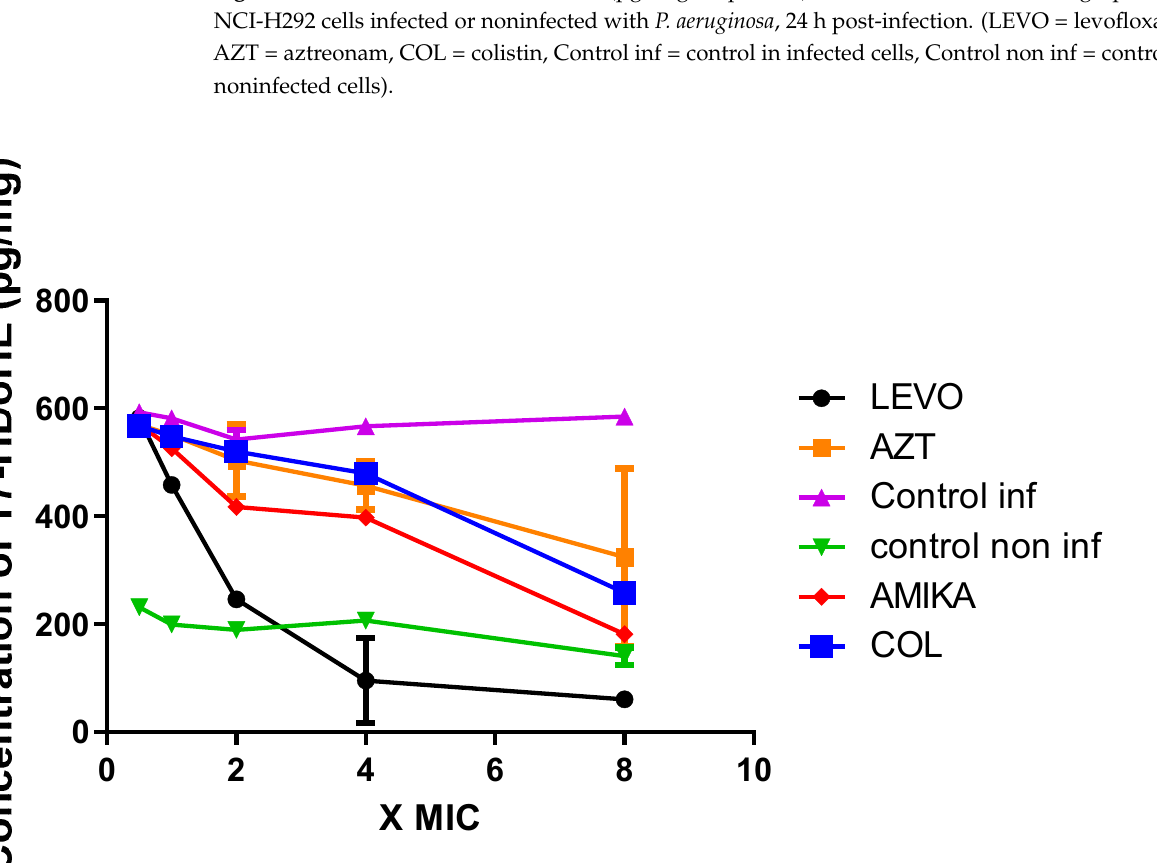
Figure 4. Concentration of 15-HETE (pg/mg of protein) in extracts of human lung epithelial NCI- H292 cells infected or noninfected with P. aeruginosa , 24 h post-infection. (LEVO = levofloxacin, AZT = aztreonam, COL = colistin, Control inf = control in infected cells, Control non inf = control in non- infected cells).